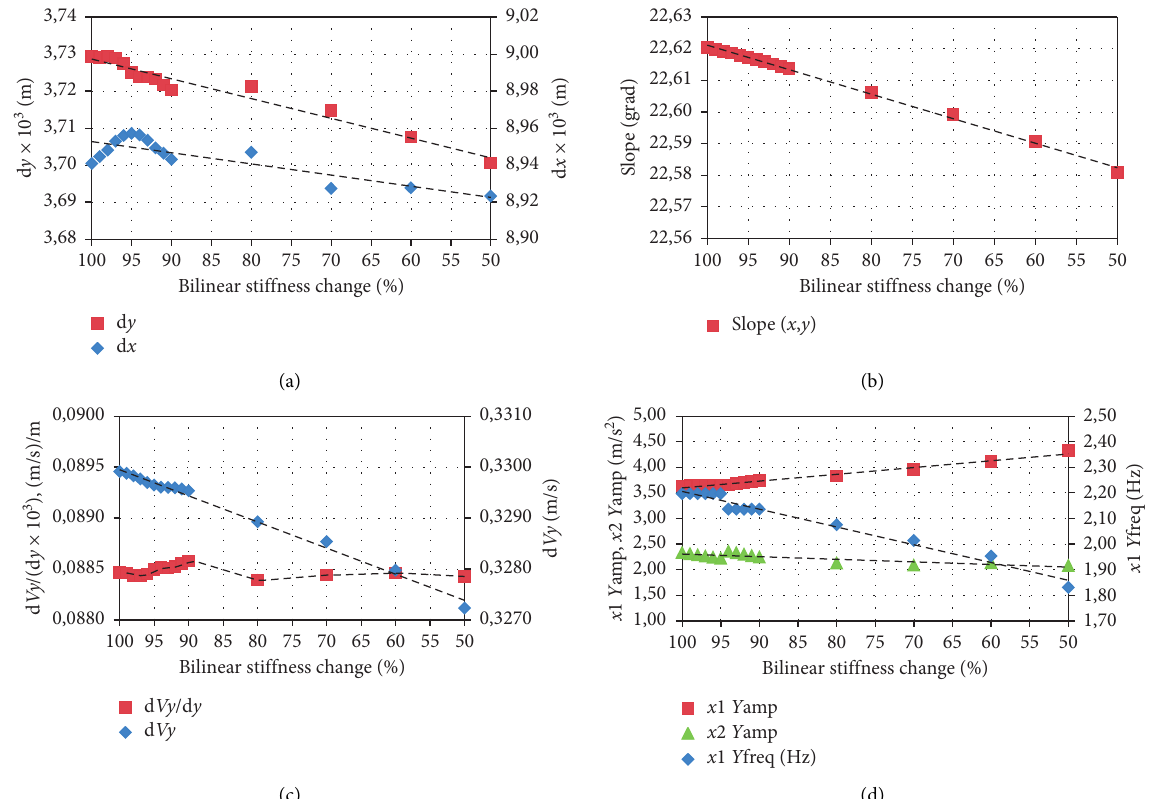
Figure 9: Investigation on the model diagnostic parameters of vibrating screen springs: (a) orbit size (d x ; d y ); (b) orbit slope ( x ; y ); (c) form of phase space plot (d Yy /d y ) (d Vy ); (d) natural frequency ( x 1 Yfreq) and amplitudes of first ( x 1 Yamp) and second ( x 2 Yamp) harmonics.